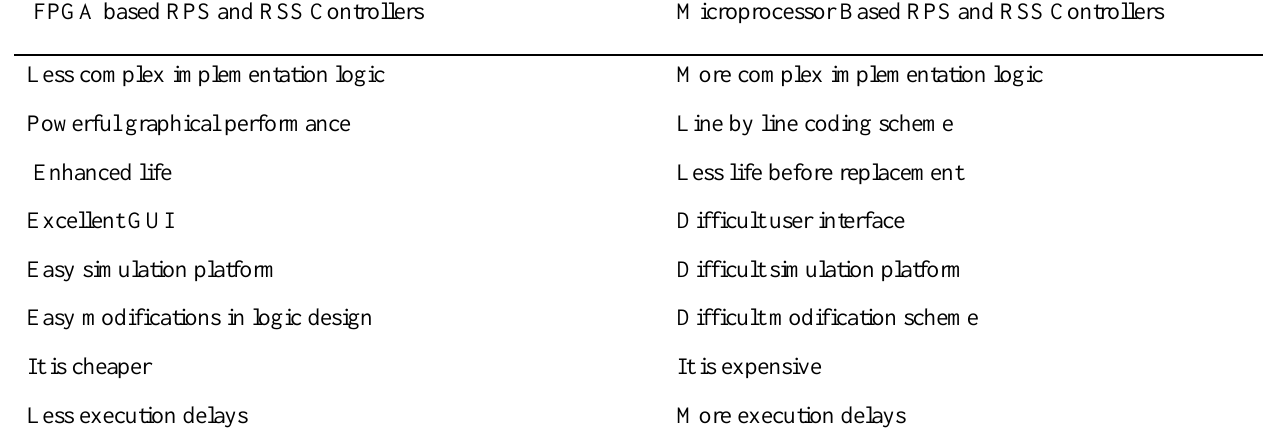
Table 3 Comparison of FPGA based RPS and RSS Controllers with Microprocessor Based Existing Controllers FPGA based RPS and RSS